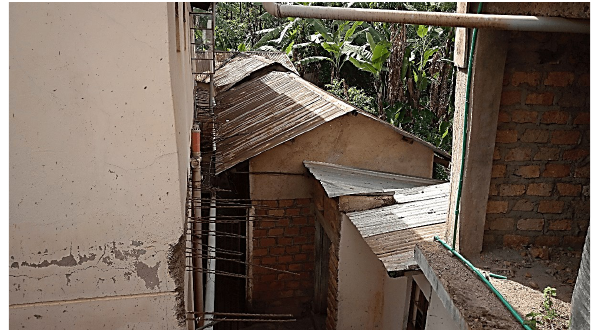
Figure 3 : Noncompliance with rear setback planning standard in Daraja Mbili In the above occurrence, the entire 4.5 metres